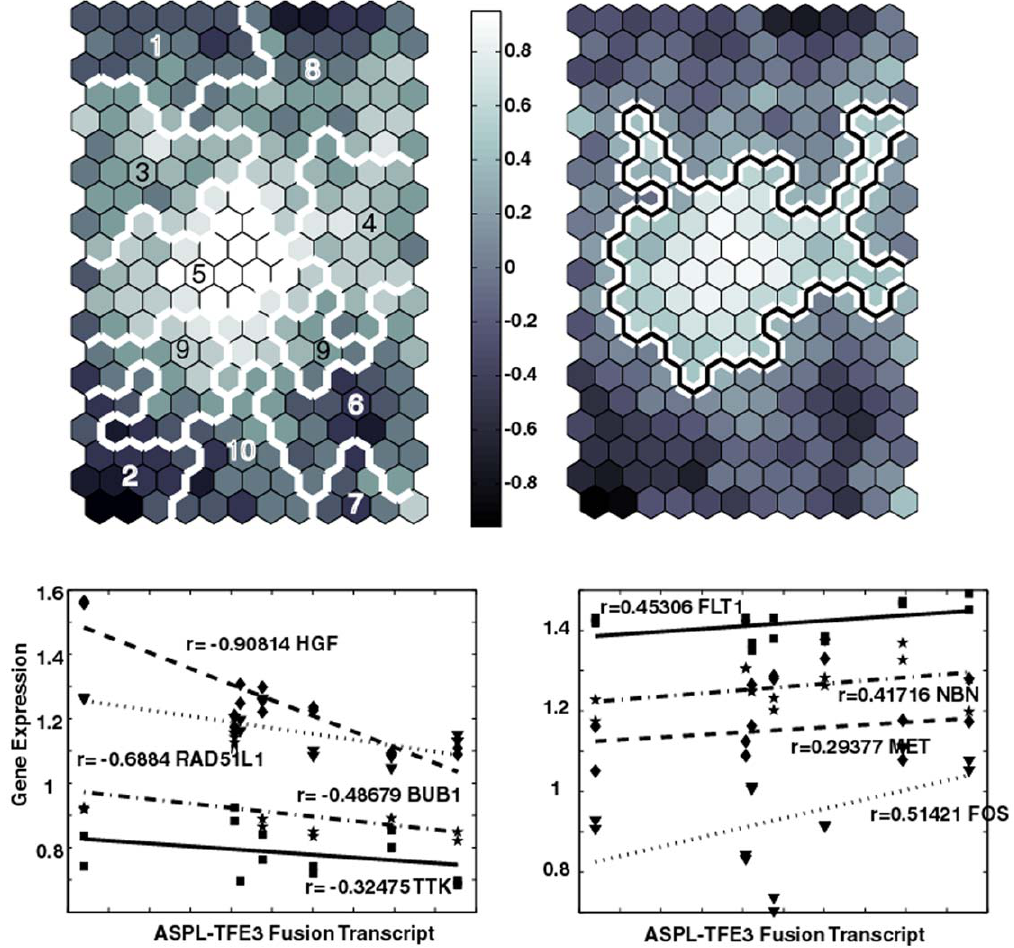
Figure 7. Upper left panel displays SOM (20 6 12) based on the 1244 6 14 patient gene measurements. Colors represent the PCCs of the ASPL-TFE3 fusion transcript values against the SOM codebook vectors for each cluster. These codebook vectors represent the best representative of the gene expressions contained within a SOM cluster (typically 5–10 genes). White boundaries correspond to SOM meta-clades. Upper right panel displays the same SOM image with the boundary line (white with black inlay) identifying clusters with the most significant positive PCC values (ASPL- TFE3 fusion transcript versus patient gene expressions). The region scribed by this boundary encompasses most of SOM meta-clade 5, and includes portions of SOM meta-clades 3, 4, 8 and 9. Lower panels plot patient ASPL-TFE3 fusion transcript to gene expressions for selected genes. Lower left and right panels depict examples of negatively and positively correlated genes, respectively. Positive: FLT1:SOM meta-clade 8 MET:SOM meta-clade 9, PGF SOM meta-clade 3, NBN SOM meta-clade 8. Negative: HGF:SOM meta-clade 2, BUB1:SOM meta-clade 1, RAD51L1:SOM meta-clade 7,